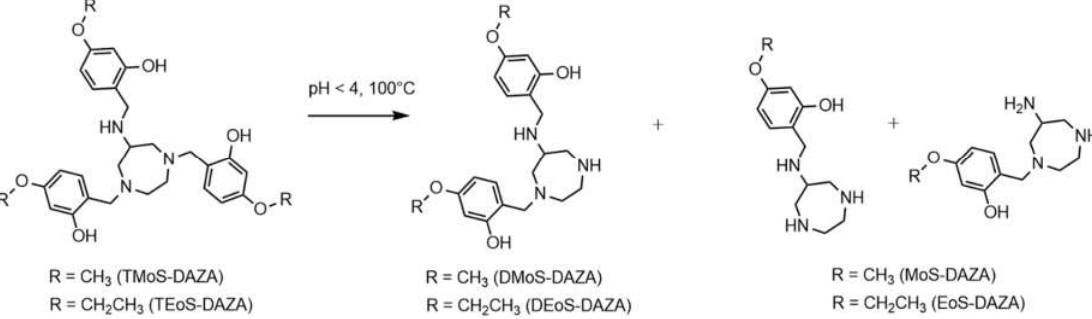
Figure 2. Structure of DEoS-DAZA and DMoS-DAZA (di-alkylated), respectively, and EoS-DAZA and MoS-DAZA (mono-alkylated), respectively, which are formed under acidic conditions. DEoS- DAZA and DMoS-DAZA are penta-dentate chelators that bind to 68 Ga as well, thereby forming a radioactive impurity in the final product solutions.